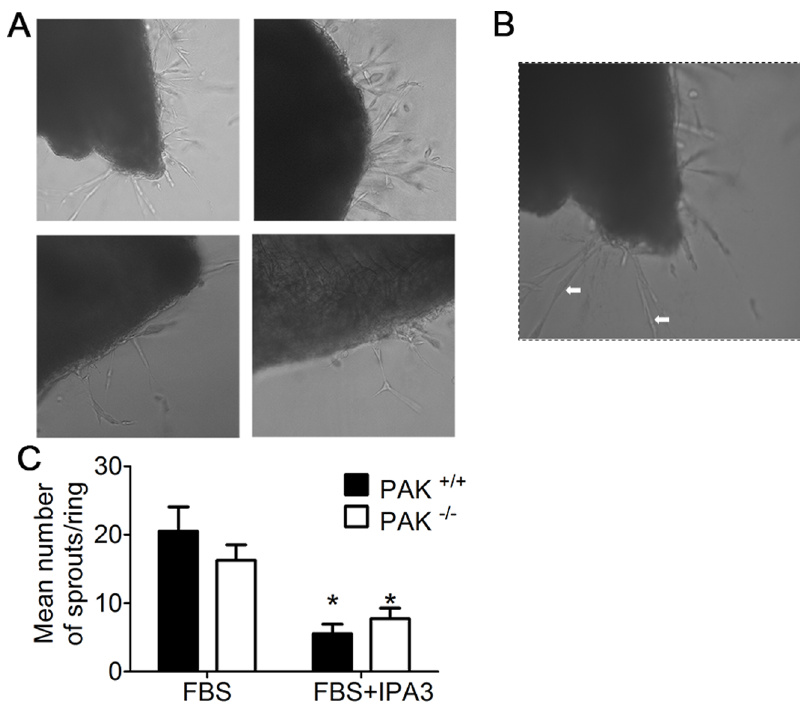
Figure 5. Marked reduction in aortic EC sprouting following IPA3 treatment. A) Similar EC sprouting is observed in PAK1 2 / 2 and PAK + / + aortic rings cultured for 5 days in growth media supplemented with FBS, whereas a notable reduction in sprouting was observed following 30 m M IPA3 treatment. B) Magnification of the selected region showing EC sprouts (white arrows). C) Quantification of EC sprouts shows less EC sprouts in PAK1 + / + and PAK1 2 / 2 with IPA3 treatment. Data points represent the average values 6 SEM from 3–9 rings from 3–4 mice per group; * denotes p ,